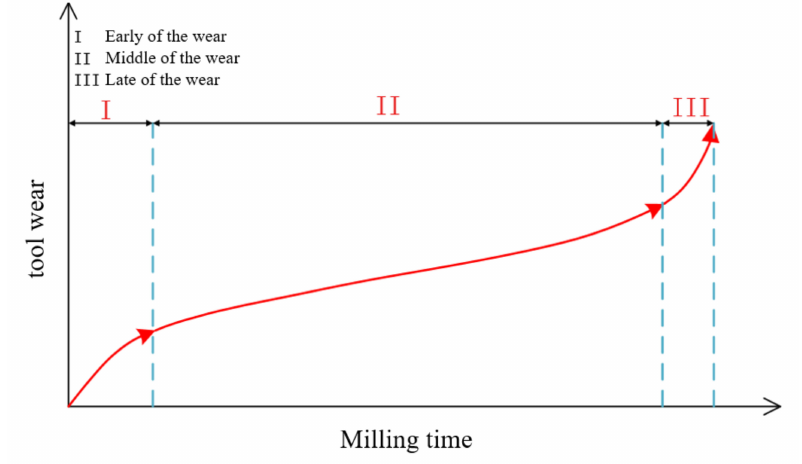
Figure 5. Time-varying curve of tool